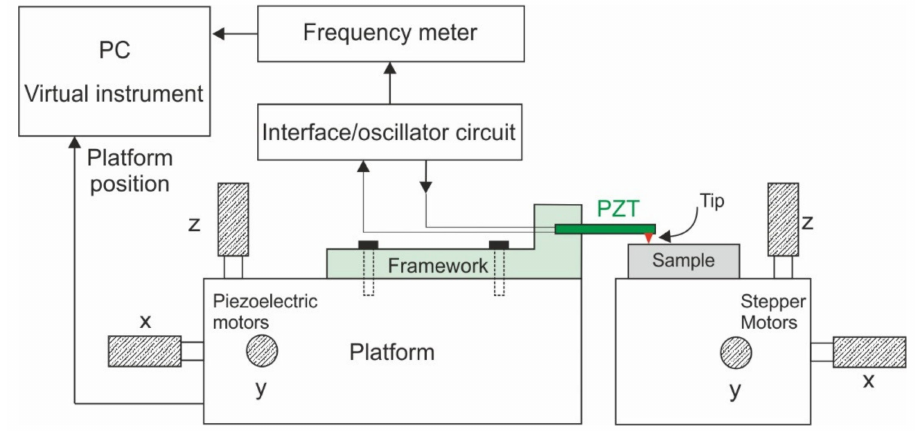
Figure 3. Schematic of the setup for the modulus of elasticity measurements.